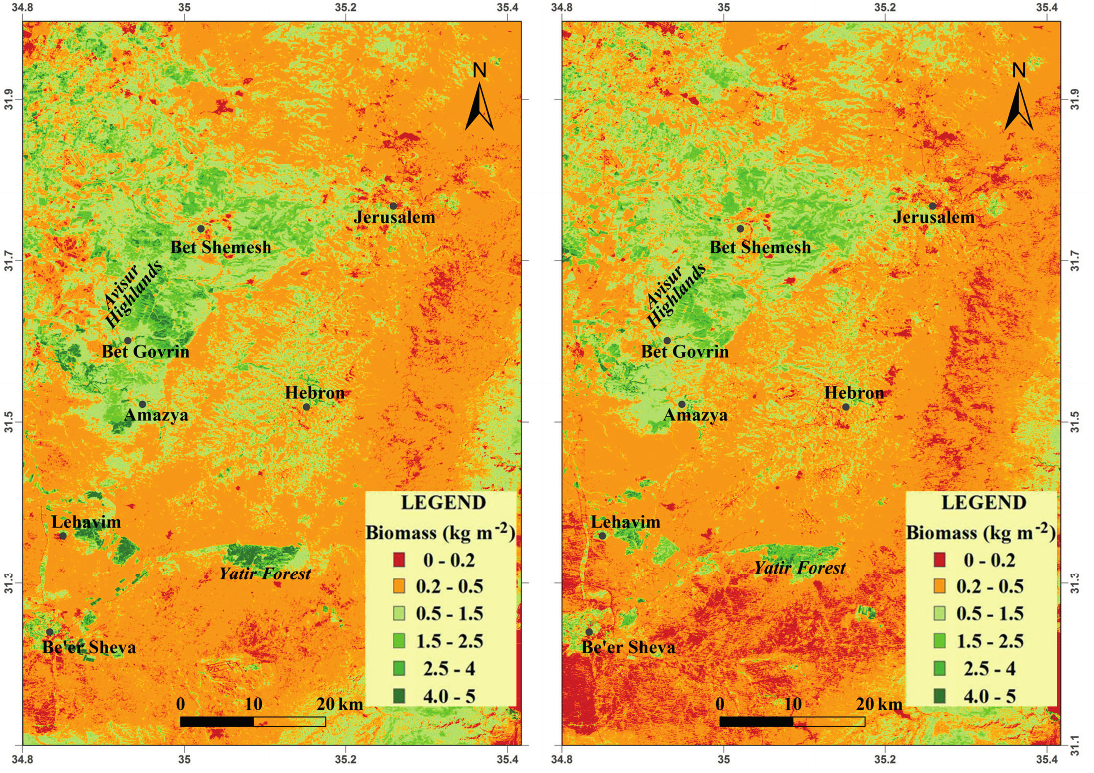
Figure 10. Maps of model-predicted biomass (Equation (5)): Left: average of 1994, 1995 and 1996. Right: average of 2009, 2010 and